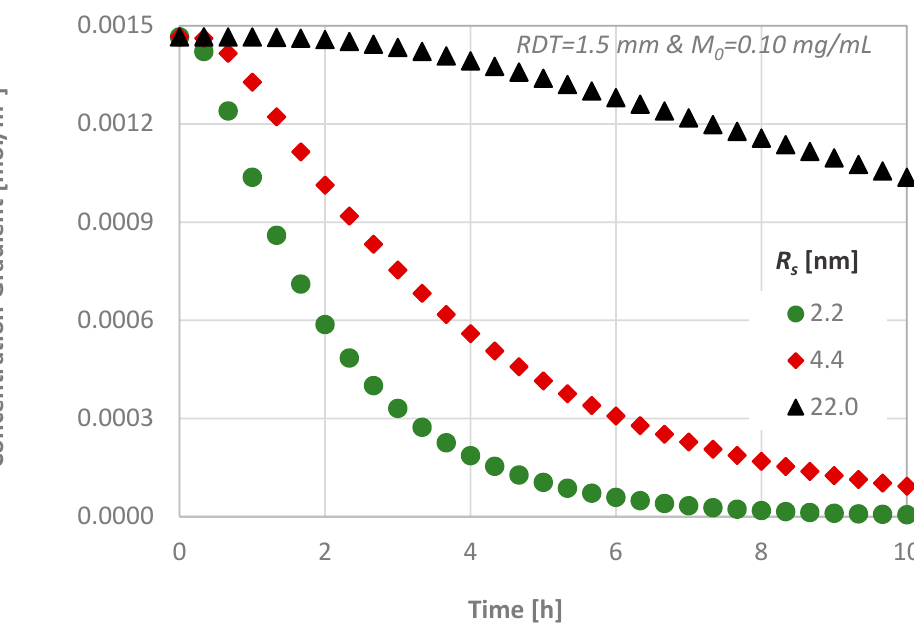
Figure 10. Effect of the molecular size on the diffusion characteristics; concentration gradient versus time.